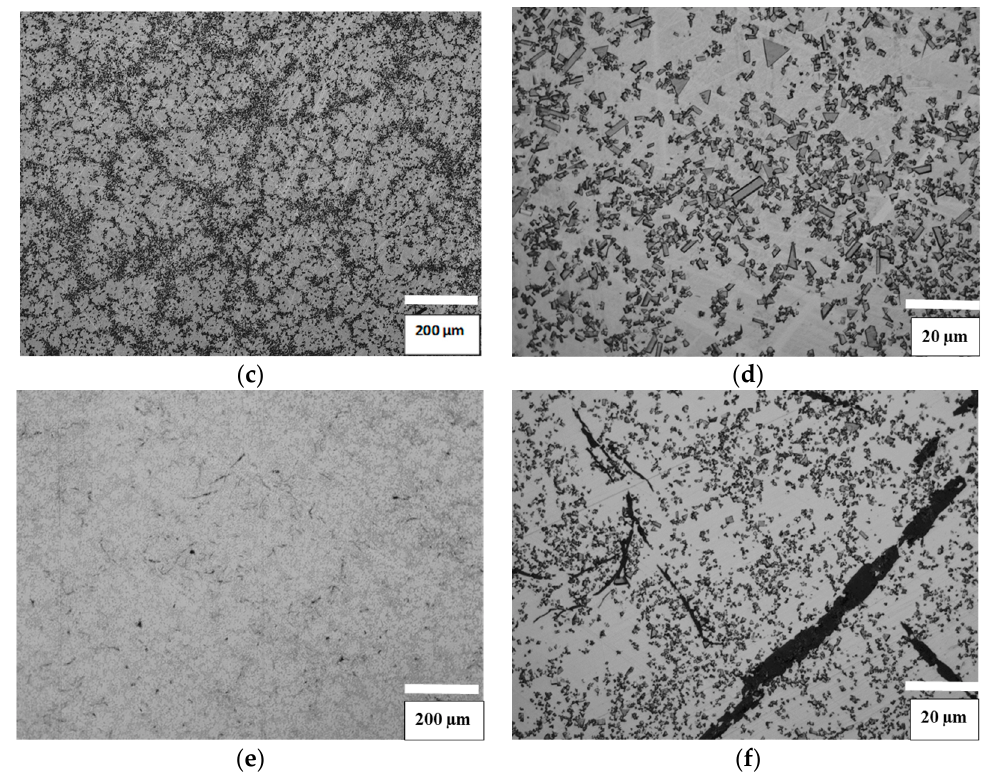
Figure 1. Microstructures of model binder alloys with various carbon contents after their original sintering at a temperature of 1500 °C: ( a , b ) With a low carbon content ( a ) needle-like WC grains and ( b ) Dendritic η -phase crystals); ( c , d ) With a medium-low carbon content at different magnifications; ( e , f ) With a high carbon content at different magnifications. All of the micrographs except for ( e ) are obtained after etching in the Murakami reagent.